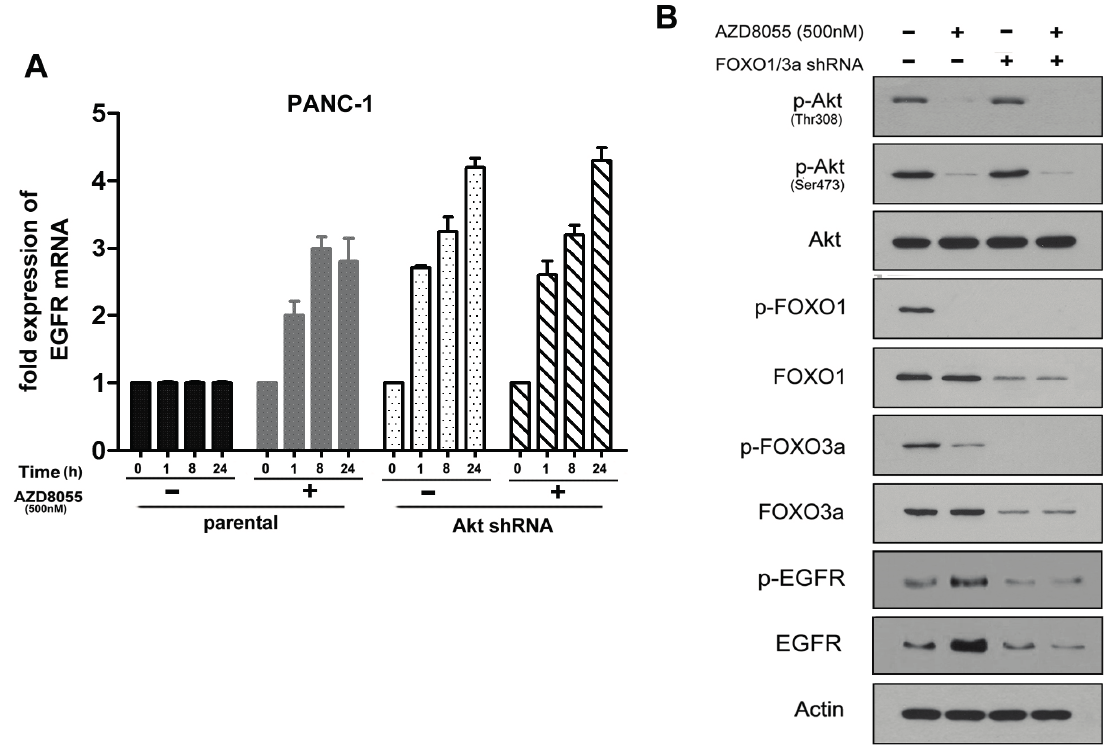
Figure 3. AKT inhibition induces EGFR upregulation in mRNA level in a Fork-head box O (FoxO)-dependent manner. ( A ) PANC-1 cells were transfected with AKT shRNA and treated with AZD8055 for indicated hours, then relative fold change of EGFR mRNA were analyzed by RT-PCR. GAPDH was used as a blank control. Error bars represent as mean ± SD.; ( B ) PANC-1 cells were transfected with FoxO1/FoxO3a siRNAs and treated with AZD8055 for 1 h, then AKT (T/P), FoxO1 (T/P), FoxO3a (T/P) and EGFR (T/P) proteins were examined by